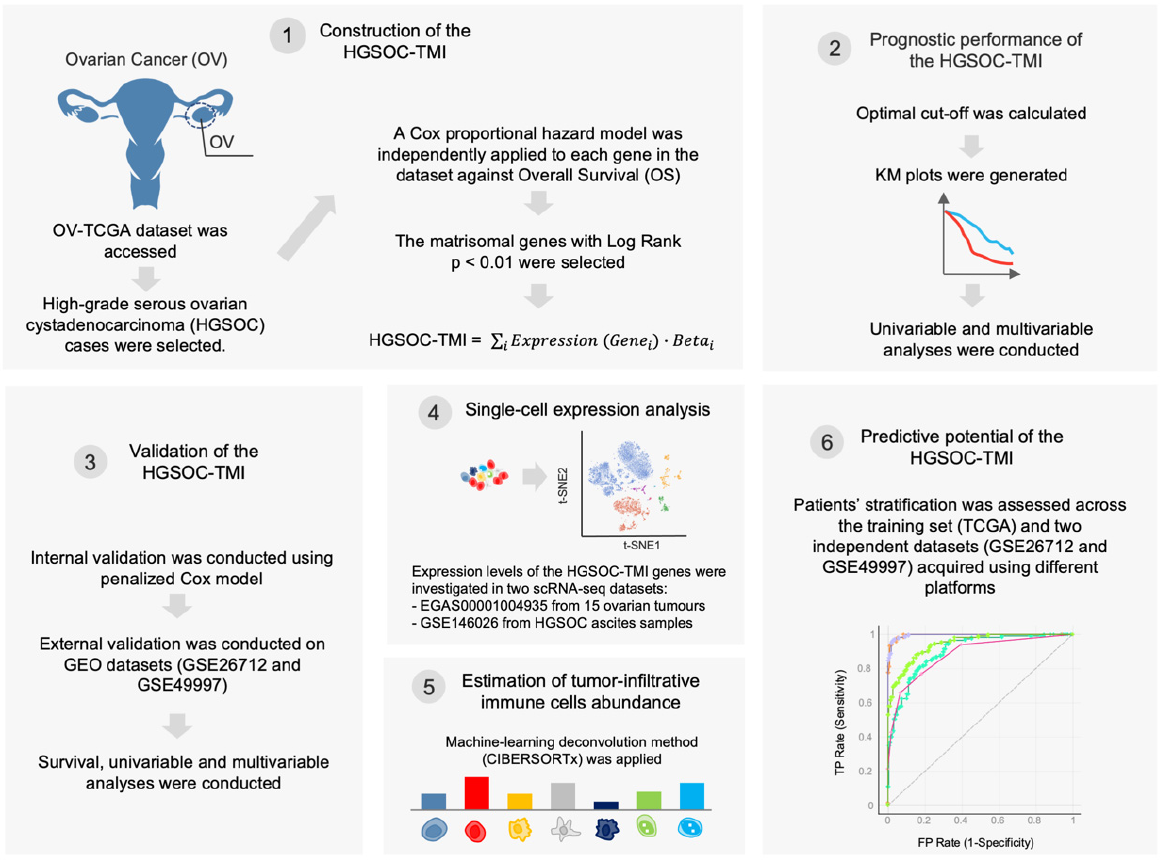
Figure 1. Schematic of the bioinformatics workflow. First, The Cancer Genome Atlas (TCGA) ovarian cancer (OV) dataset was accessed, and the high-grade serous ovarian carcinoma cases were selected. A Cox proportional hazard model was used to identify matrisome-associated prognostic genes. The HGSOC-TMI risk score was computed, and two risk groups were identified by using an optimal cutoff. The overall survival probabilities for each risk group are shown in Kaplan–Meier (KM) plots. The HGSOC-TMI risk score was internally and externally validated by using two independent GEO datasets. A machine-learning-based deconvolution tool (CIBERSORTx) was then used to investigate the abundance of infiltrating immune cells for each risk group. Finally, machine-learning multiclass supervised classification was performed to test the predictive abilities of the HGSOC-TMI across different platforms.